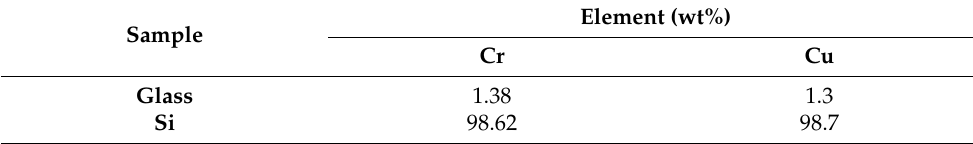
Table 2. EDS spectra data for glass and Si substrates.